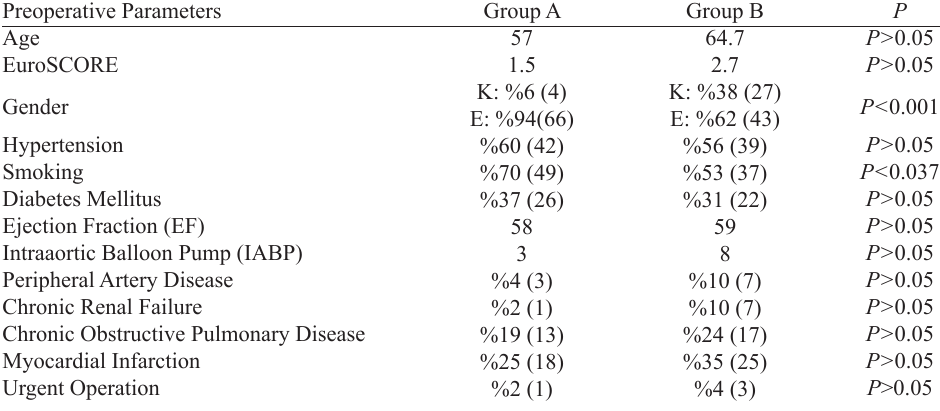
Table 1. Comparison of the basal charecterictics, preoperative echocardiografic and clinical parameters among patients from Group A and Group B.